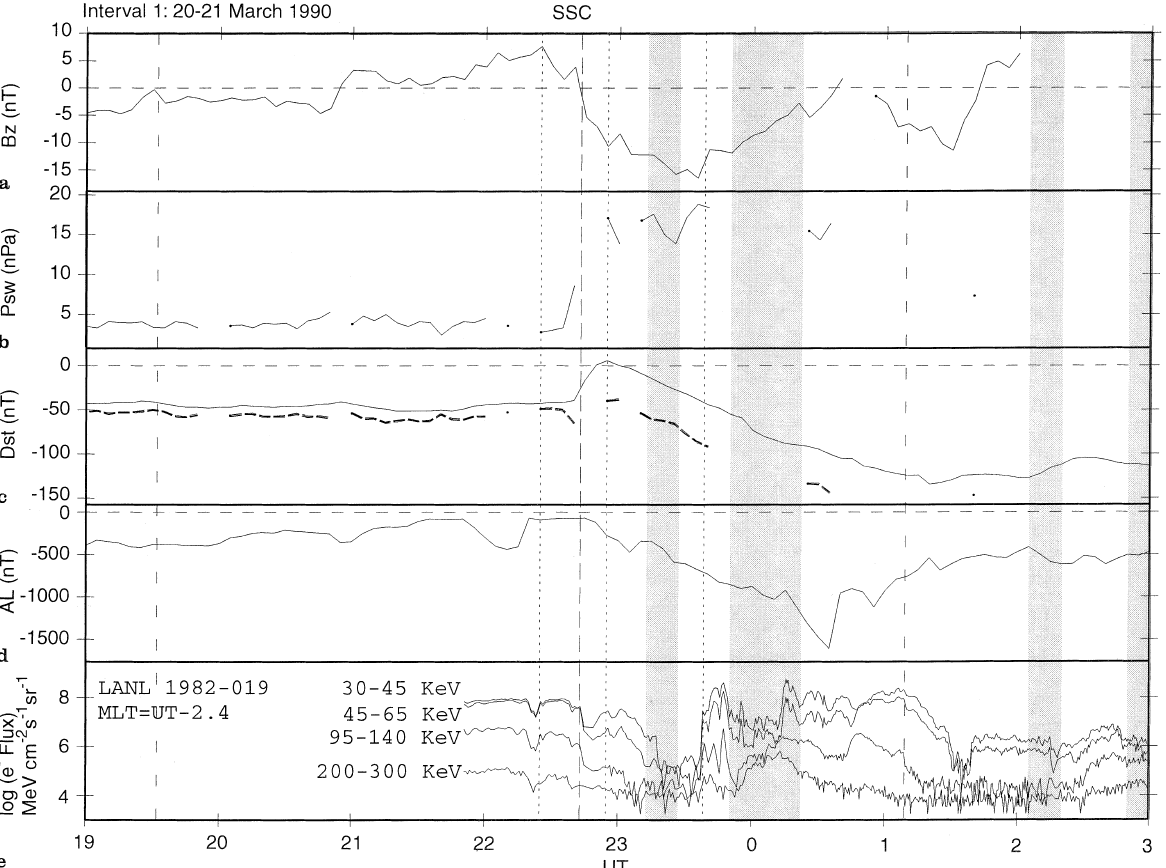
represent the time of substorm expansion phase onsets identified from z ground magnetometer data (- - - -) and particle injection events , c sw identified from LANL spacecraft data ( (cid:225) (cid:225) (cid:225) (cid:225) (cid:225) (cid:225) ). Where multiple onsets have occurred, shaded bars are used to indicate the range of onsets. The time of the SSC is represented by the (- - - - -) line, see text